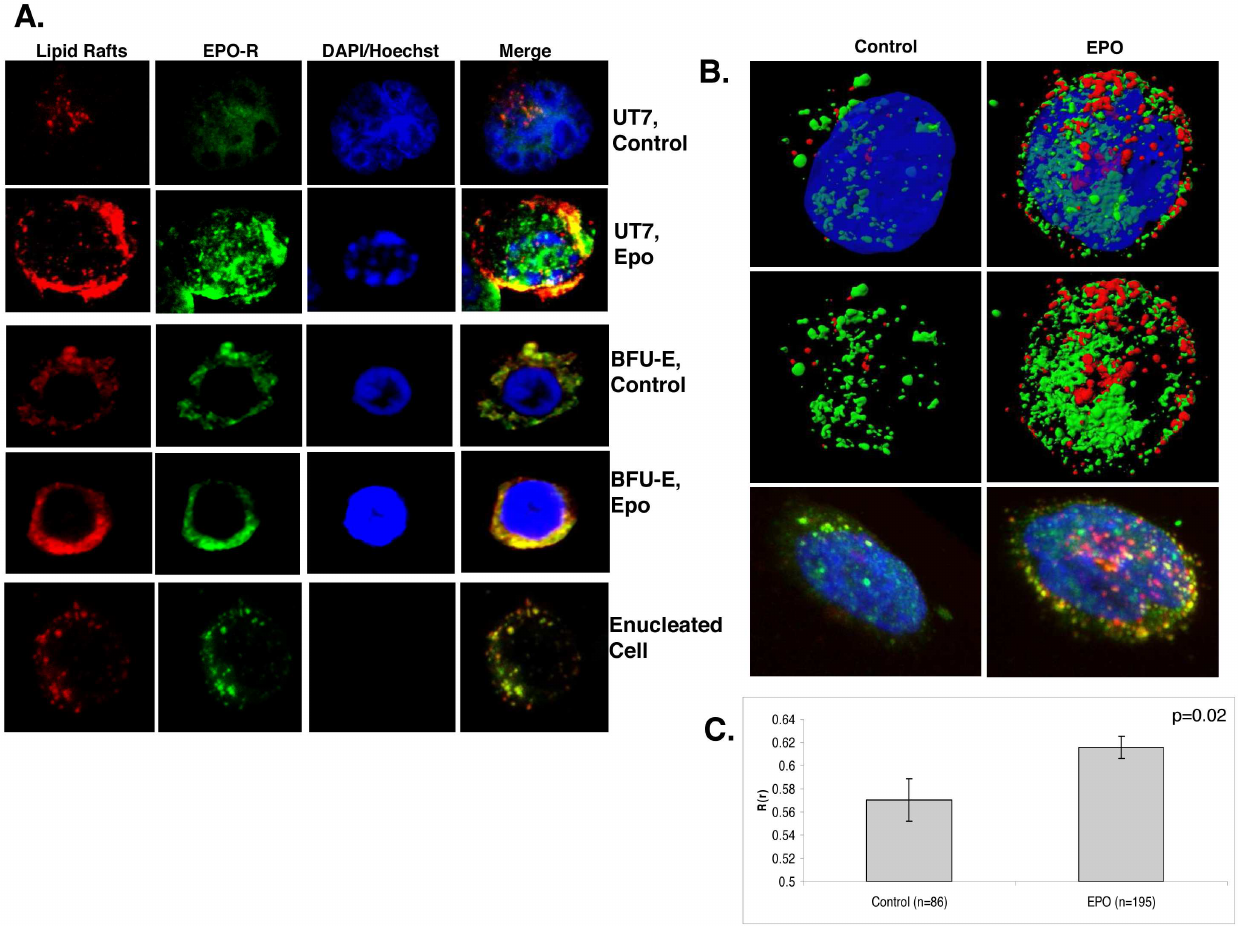
Figure 2. Epo-R co-localizes with lipid rafts. (A) Confocal immunofluorescence of cells untreated or after Epo stimulation, lipid rafts:red, Epo- R:green, DAPI/Hoechst:blue. Right panel is a merged image showing lipid raft and Epo-R co-localization (yellow). UT7 cells are shown in rows 1 and 2, while human primary burst forming units are shown in rows 3 and 4, followed by a maturing, enucleated erythroid precursor in row 5. (B) Three dimensional rendering of UT7 cells either untreated (left) or after Epo treatment (right). Top two rows display isosurfacing of the rafts (red), Epo-R (green), and nucleus (Dapi, blue). Dapi was removed from the middle row to further visualize association of the receptor with rafts in the second row of panels. The bottom row displays volume rendering of the same cells to illustrate membrane colocalization (yellow). (C) Quantitation of colocalization in human primary erythroid cells. Values represent mean 6 SE. Immunofluorescence experiments were repeated at least 3 times, representative micrographs provided. a normal donor. After a 2 h starvation, BM-MNCs were pretreated with MBCD either with or without Epo. Cells were permeabilized and stained with antibodies to CD71, CD45, and phospho-STAT5. Epo-responsive erythroid progenitors were identified by gating on the CD45 dim population of CD71 + cells (Fig. 5A), and phospho-STAT5 mean fluorescent intensity (MFI) was determined (Fig. 5B). Treatment with MBCD significantly decreased STAT5 phosphorylation in response to Epo stimulation (Fig. 5B; P=0.01). Flow histograms show a marked shift consistent with a marked reduction in phospho-STAT5 MFI (Fig. 5C). These findings confirm that membrane raft integrity is critical to the fidelity of Epo-R signaling in primary erythroid precursors.